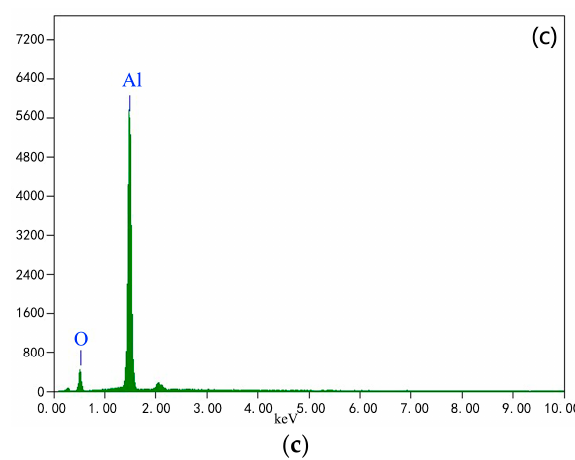
Figure 3. The microstructure of the as-deposited TBCs (Sample A) with the bond coats deposited by ( a ) shrouded plasma spraying and ( b ) high-velocity oxygen fuel spraying (HVOF); ( c ) energy dispersive spectrometer (EDS) analysis of the HVOF bond coat.